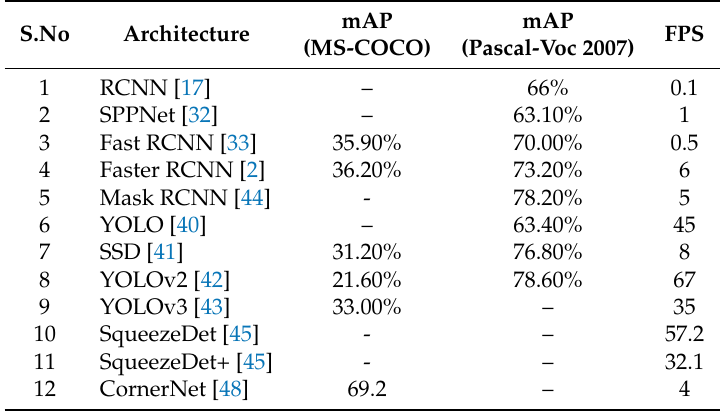
Table 1. Summary of different object detection (Pascal Titan X GPU) performances on MS-COCO and